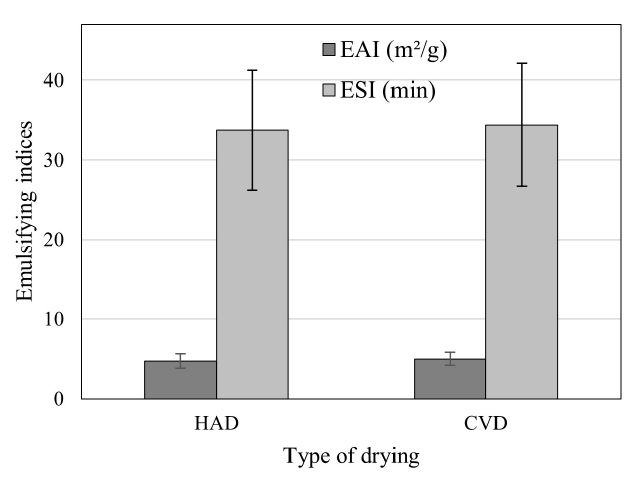
Figure 1. Emulsifying activity index (EAI) and emulsion stability index (ESI) of B. edulis powders according to different drying procedures.